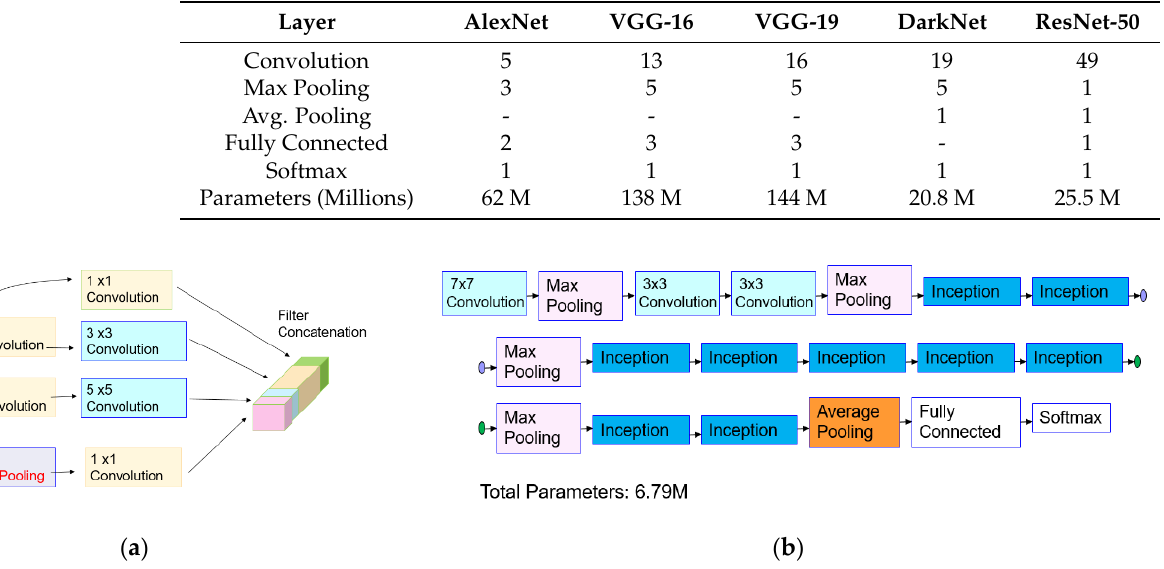
Figure 9. GoogLeNet: ( a ) inception module in GoogLeNet [23]; ( b ) summary of GoogLeNet architecture.